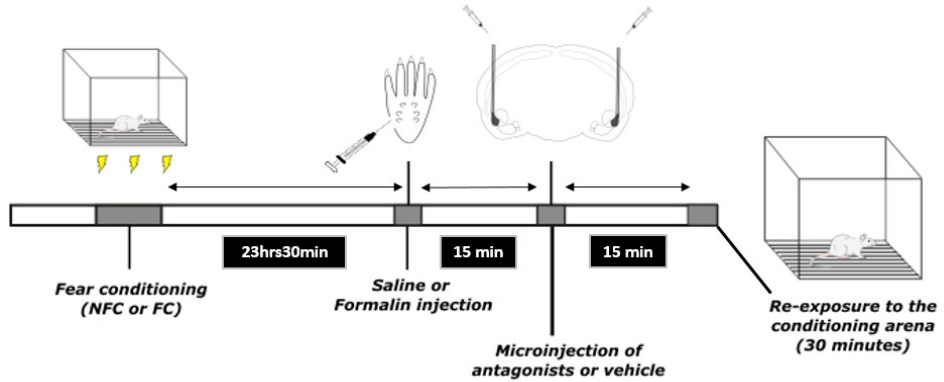
Figure 19. Graphical representation of the experimental procedure.